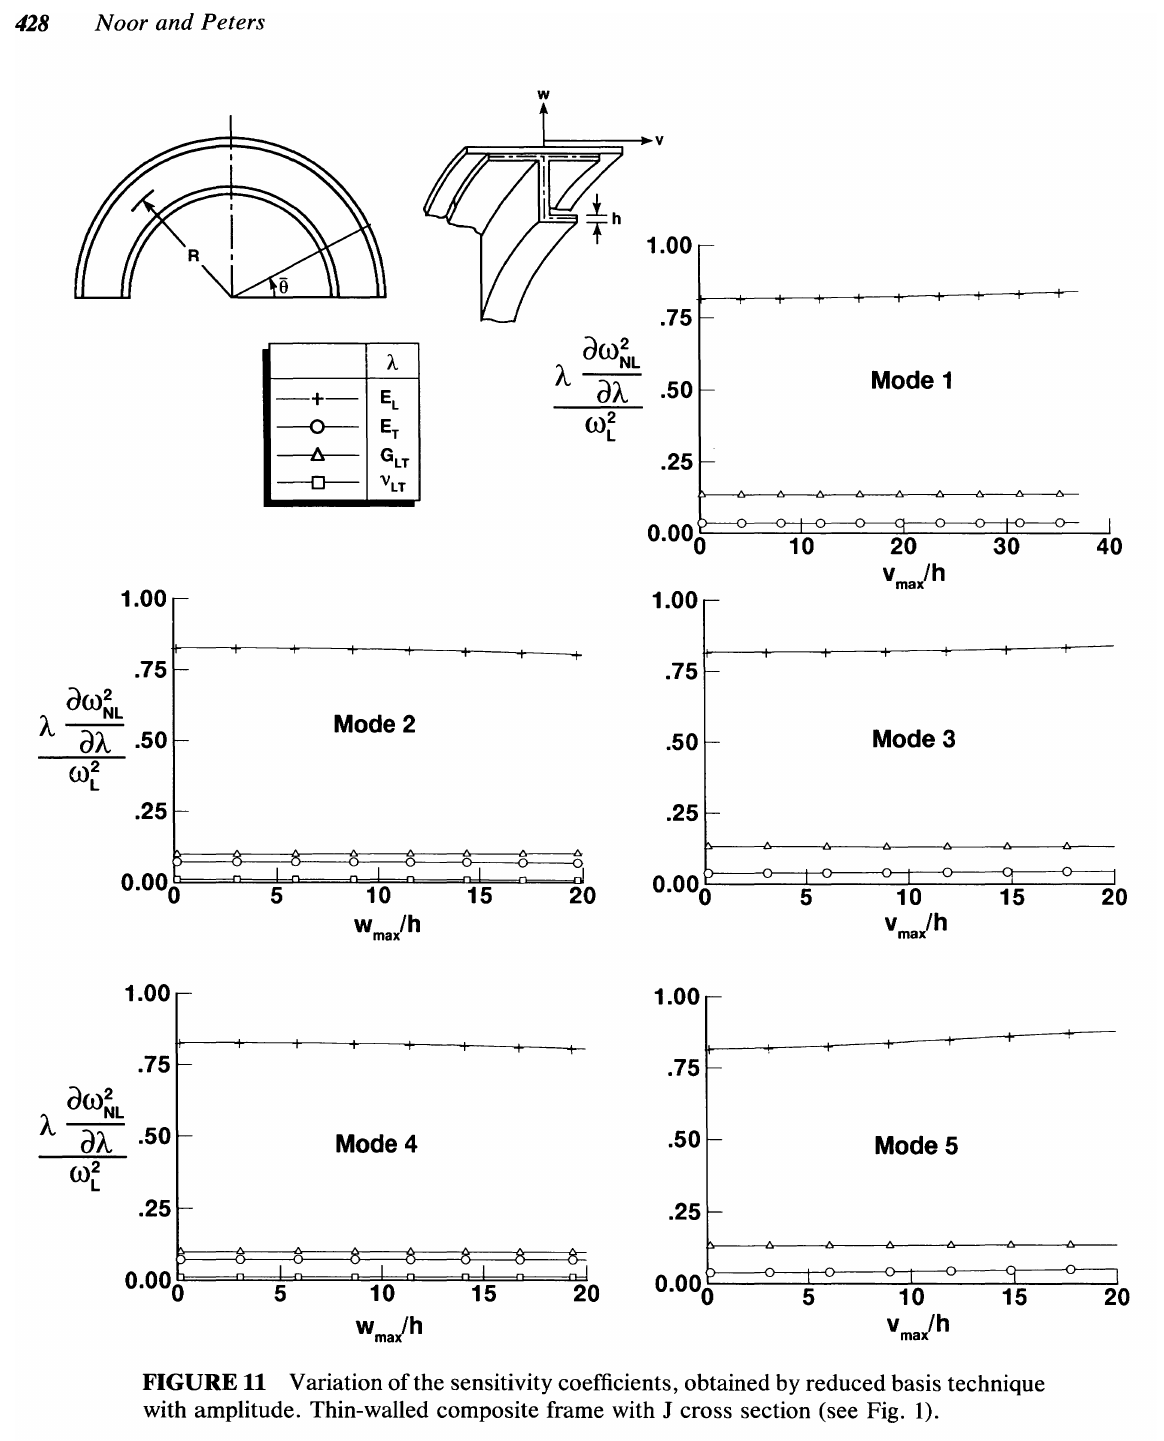
FIGURE 11 Variation of the sensitivity coefficients, obtained by reduced basis technique with amplitude. Thin-walled composite frame with J cross section (see Fig.